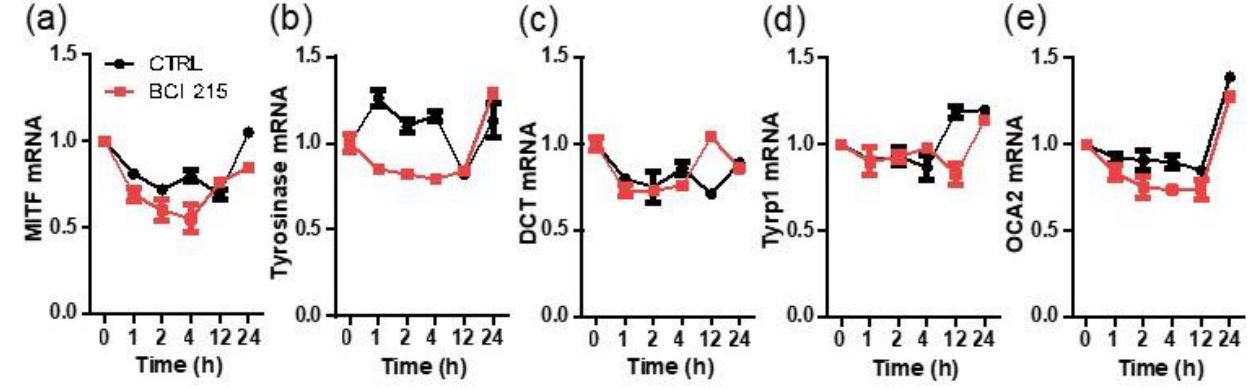
Figure 3. Effect of BCI-215 on the transcription of MITF and its downstream genes, tyrosinase, Tyrp1, DCT , and OCA2 . Time-dependent curve of the mRNA expression levels in Mel-ab cells treated with 1 µM BCI-215 for up to 24 h. ( a ) Relative value of MITF mRNA. BCI-215 decreased the transcription of MITF modestly only at an early time point. ( b – e ) Relative value of MITF target genes, including tyrosinase, Tyrp1, DCT , and OCA2 . The control mRNA curve is shown in each graph.